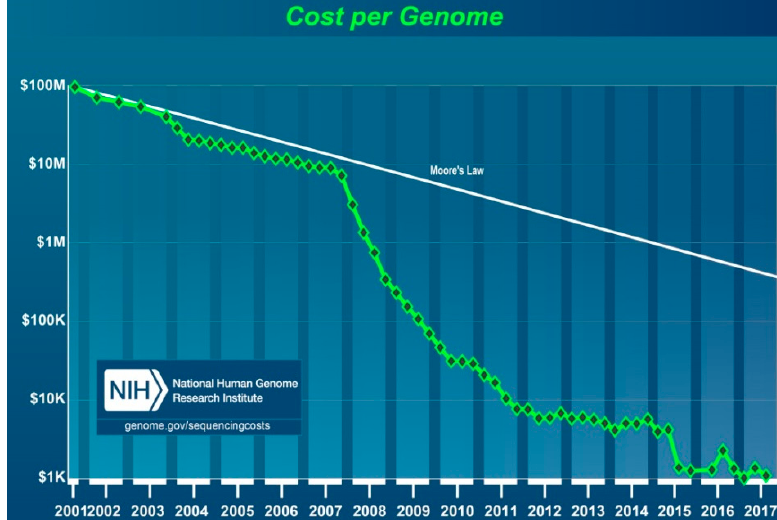
Figure 8. Costs for whole-genome sequencing (WGS). Years 2001–2007 reflect the costs of Sanger sequencing techniques, whilst the data after January 2008 reflect the costs of “second-generation” sequencing. Moore’s Law (in white) is a comparison with the normal long-term trend of progress in the computer hardware industry.